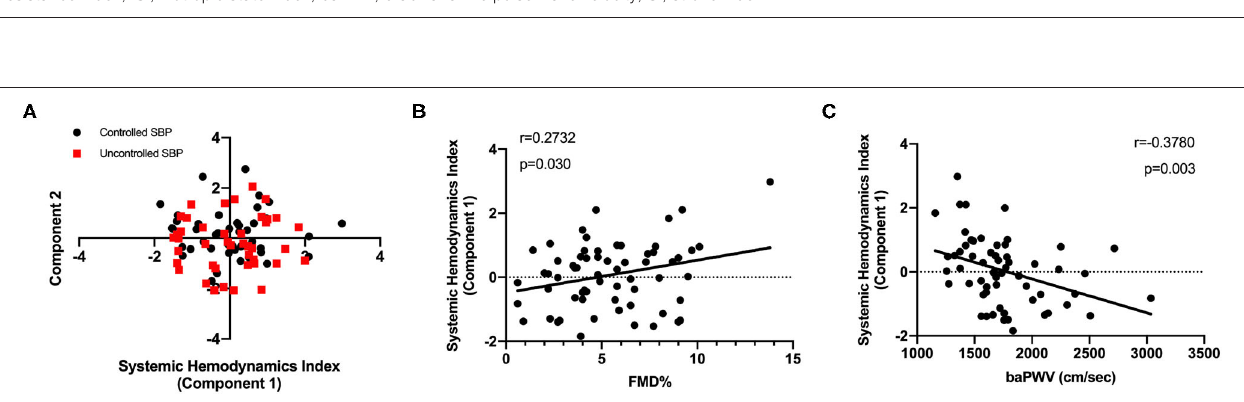
FIGURE 2 | Both baPWV and arterial compliance explained different aspects of arterial stiffness and were strongly correlated with each other ( n = 63, r = − 0.54, p < 0.0001). (H) A negative moderate ( r = − 0.29) and significant ( p = 0.02) correlation between arterial stiffness and vascular endothelial function measured by FMD was observed ( n = 60). FMD%, flow-mediated dilation percentage of baseline diameter; CI, cardiac index; LSWI, left stroke work index; SSVRI, stroke systemic vascular resistance index; ISI, inotropic state index; baPWV, brachial-ankle pulse wave velocity; SI, stroke index.